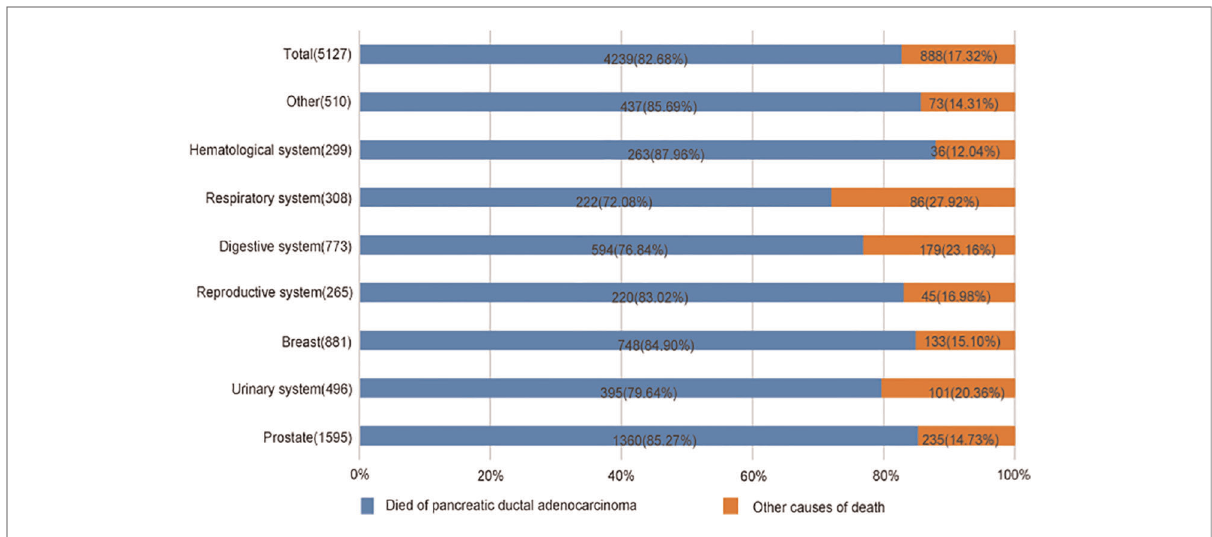
FIGURE 4 Percentage of spPDAC cancer-speci fi c and other-cause-speci fi c deaths, by location of fi rst primary cancer. Compare the proportions of causes of death in this